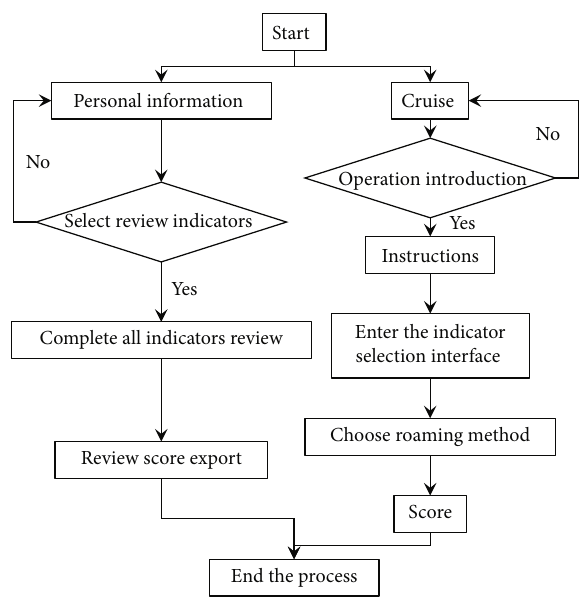
Figure 2: Memory for vocal